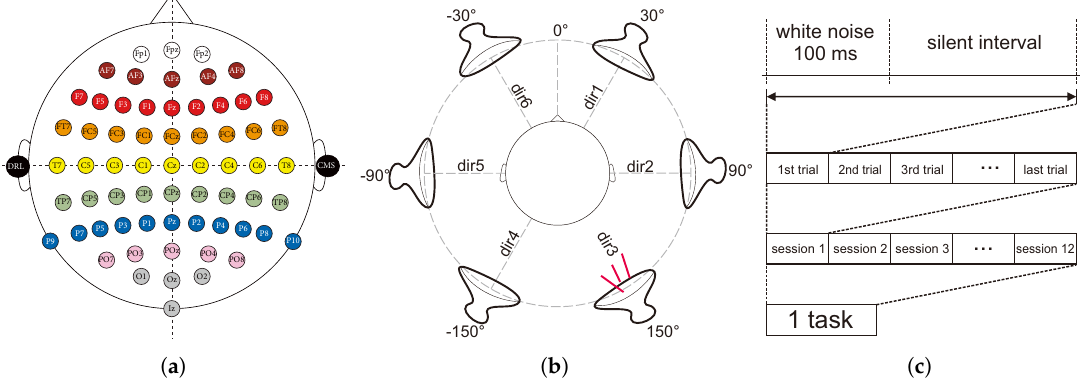
Figure 1. ( a ) 64 electroencephalogram (EEG) channel layout used in the experiments. Reference electrodes attached to the ears; ( b ) Virtual disposition of the six sound directions with respect to the user. A stimulus is being produced from Direction 3; ( c ) Task